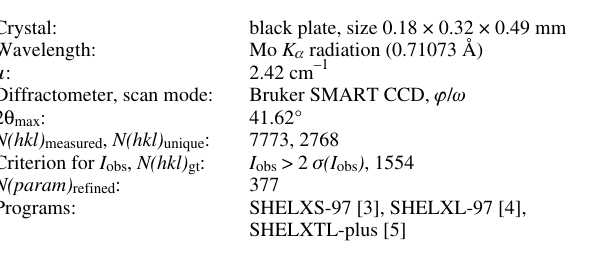
(lower figure). The two quinone rings of the pairs of molecules are related by an inversion center and as such are parallel to one another. The distance between the two quinone rings, as mea- sured between corresponding pairs of atoms, is 3.91(3) Å.